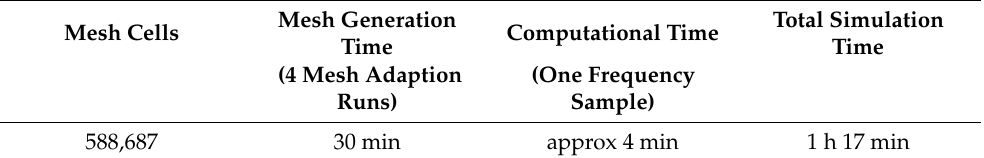
Table 2. Computational effort of the 3D numerical simulations using an Intel Xeon E5-2680V2 (10 × 2.8 GHz) and a peak memory usage of 18.9 GB. The results were obtained by using FEM in the frequency domain with tetrahedral mesh